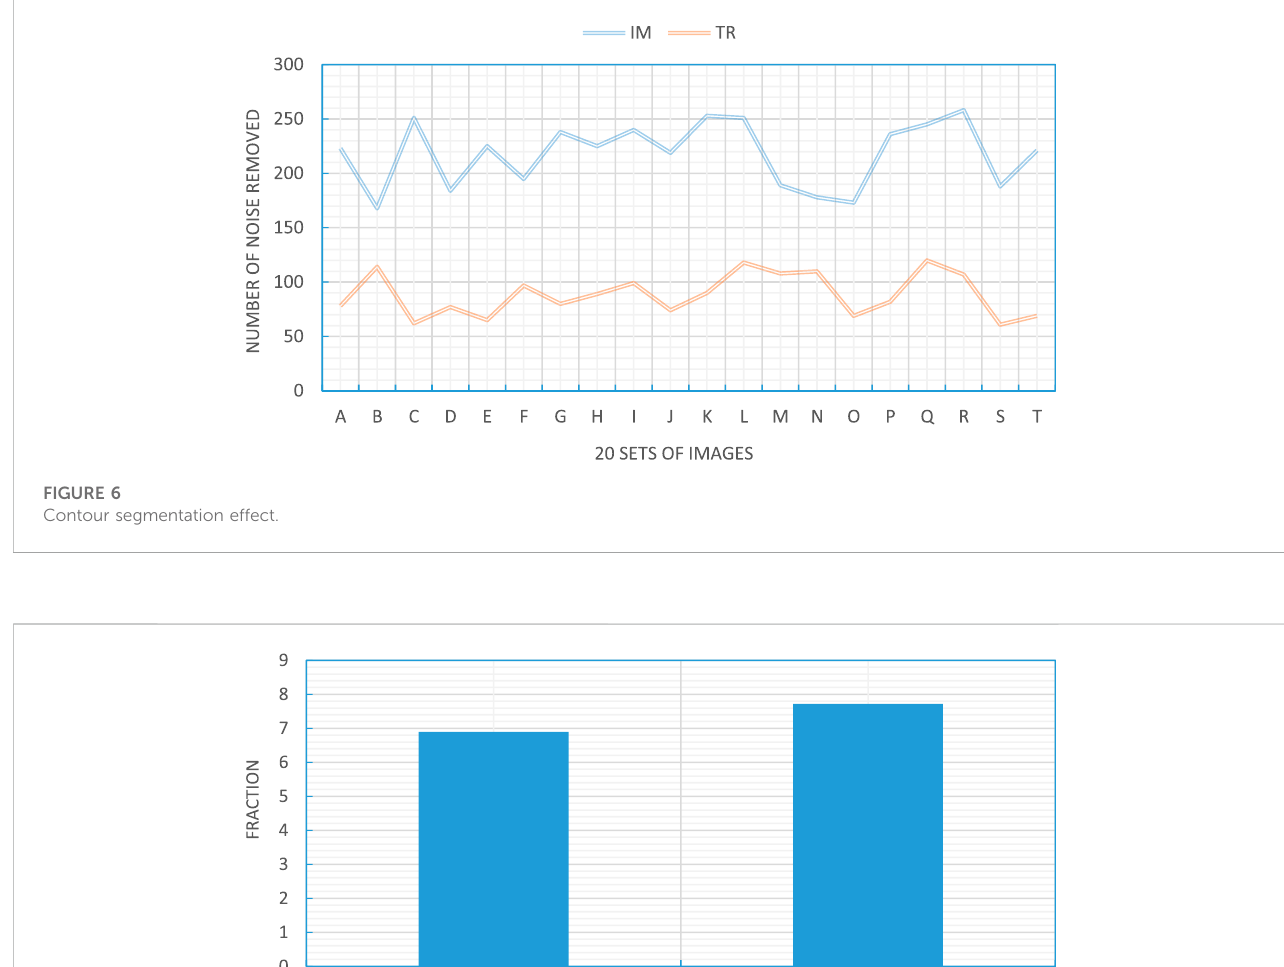
FIGURE 7 Comprehensive effect of edge